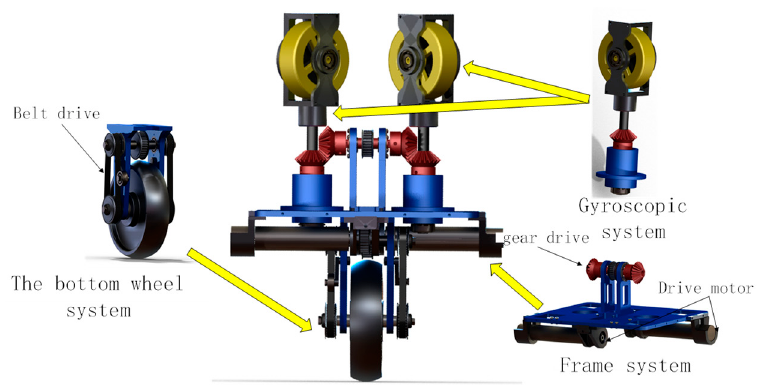
Figure 3. CAD model of the unicycle robot.